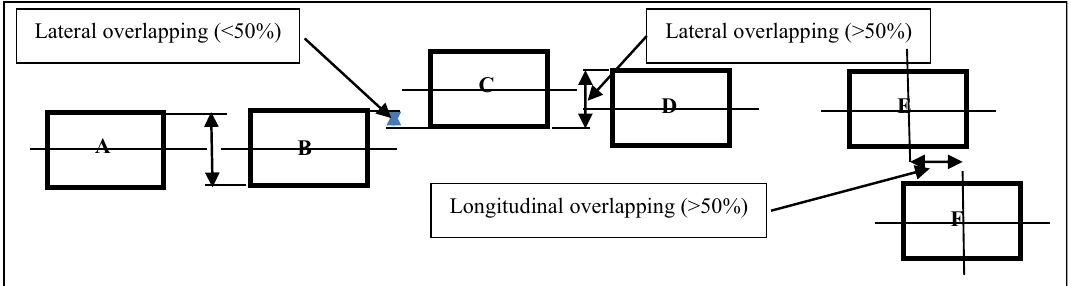
Fig. 7 Lateral and longitudinal overlapping in